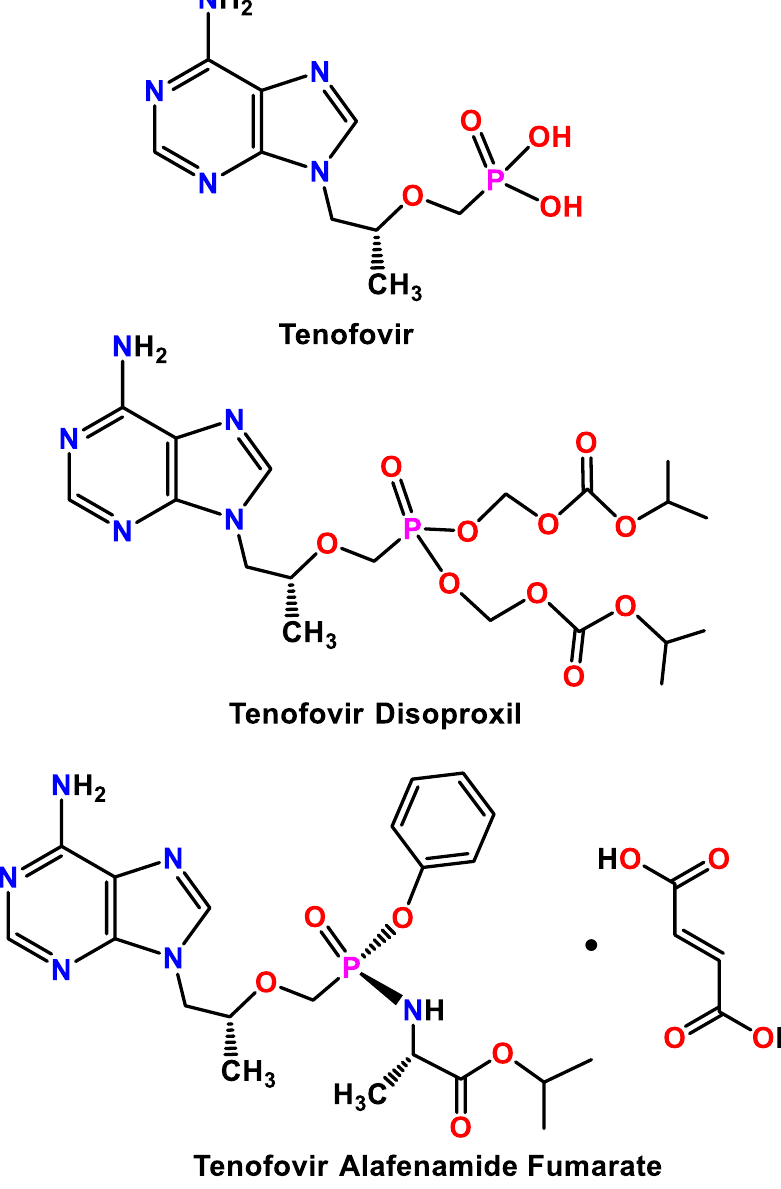
Figure 1. The structures of tenofovir, tenofovir disoproxil, and tenofovir alafenamide fumarate Accordingly, TF derivatives, particularly tenofovir disoproxil (TDF, Figure 1), in combination with the other drugs cobicistat, elvitegravir, emtricitabine, and rilpivirine, have been extensively exploited as prodrugs of TF for the treatment of HIV-1 infections [11,13]. Compared to the native TF, TDF is designed to improve TF permeability, allowing a systemic drug delivery via oral administration. However, TDF is quickly metabolized to TF by gut and serum esterases in vivo, and a high drug exposure is thus needed to allow the proper loading of target cells, raising concerns about side e ff ects such as renal and bone toxicity